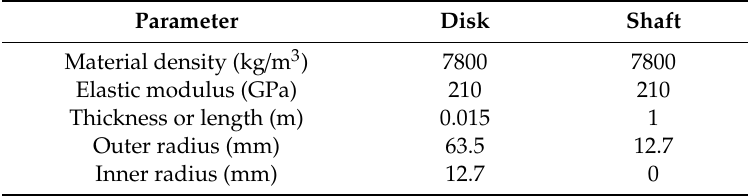
Figure 12. 2-D finite element model of a cracked rotor with disks at nodes 4 and 18. Table 3. Physical specifications of the rotor model.